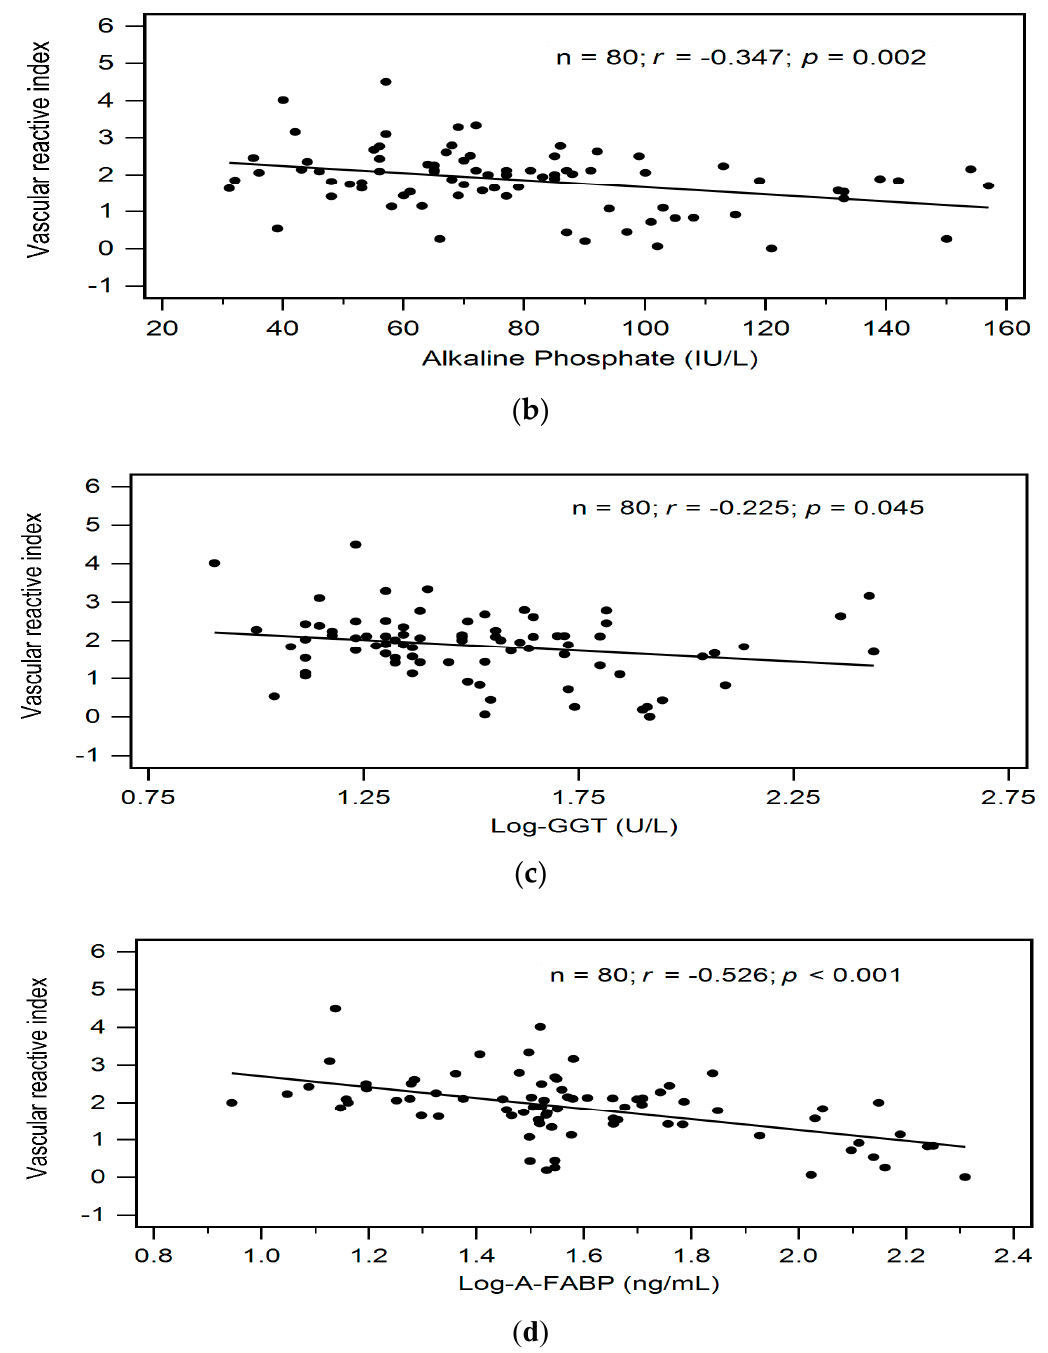
Figure 1. Relationships between vascular reactive index and ( a ) Age (years), ( b ) Alkaline phosphatase level (IU/L), ( c ) Log-GGT level (U/L), or ( d ) Log-A-FABP level (ng/mL) among 80 KT patients.